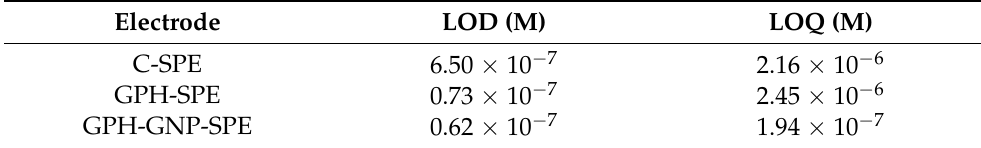
Table 2. LOD and LOQ values of CGA for all three electrodes [54].